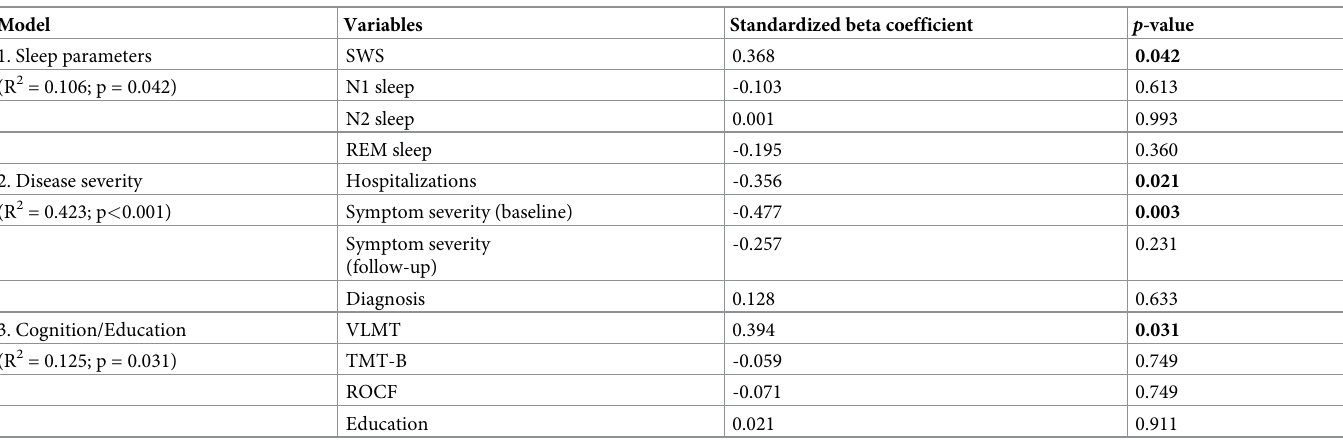
Table 2. Explorative multiple regression